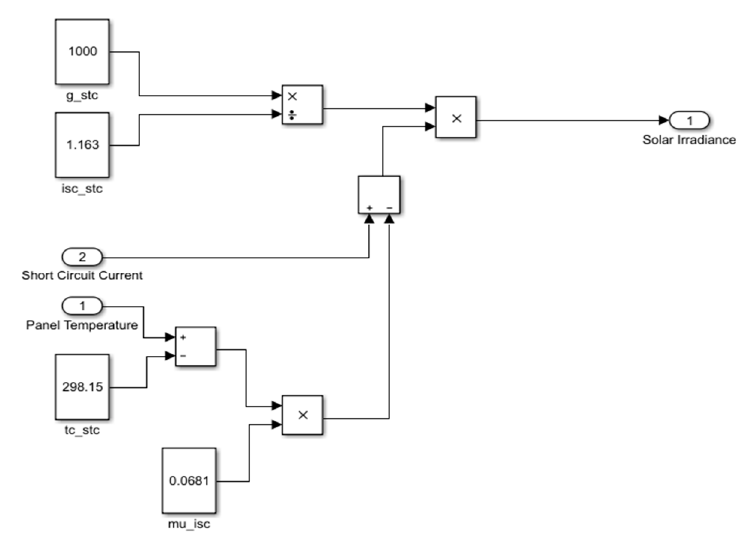
Figure 18. Subsystem to find solar irradiance value.